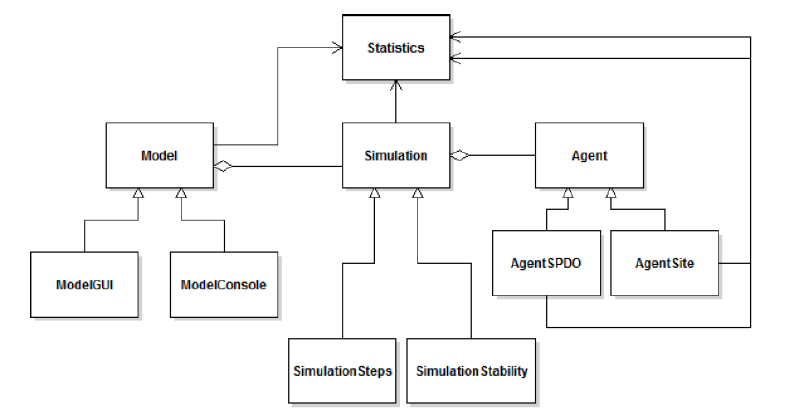
Figure 4. Excerpt of the simulation framework.